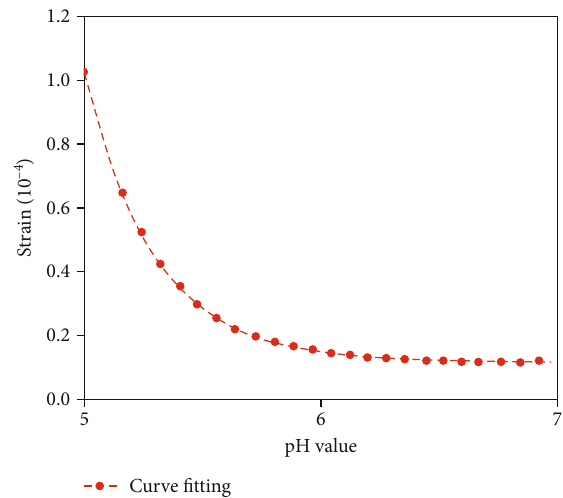
Figure 12: Strain rate during steady-state creep under di ff erent